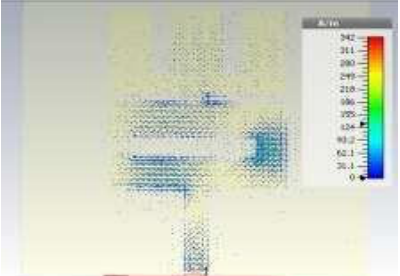
Figure 5.1: Surface current at 1.8GHz.